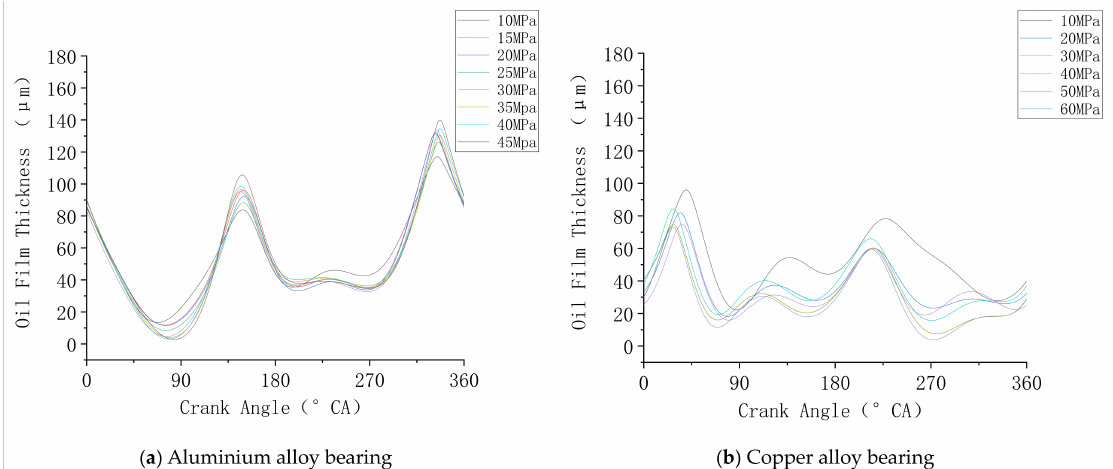
Figure 4. Comparison of oil film thicknesses of different bearing